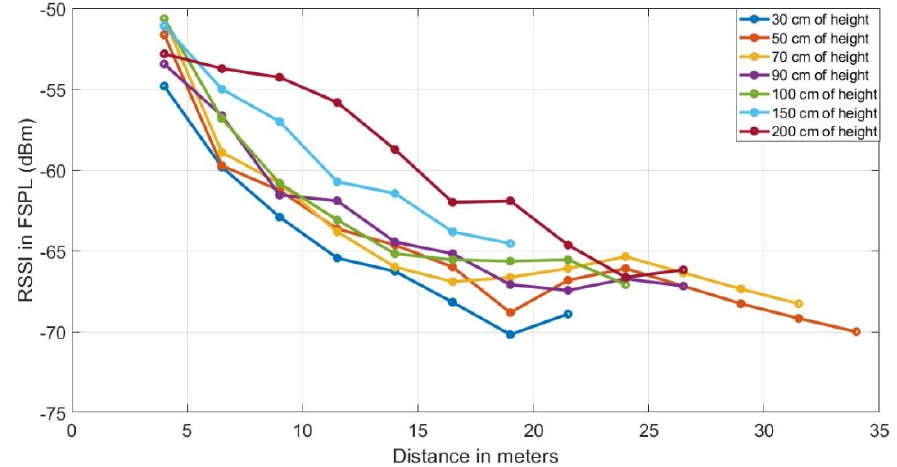
Figure 4. Received signal level average in dBm of the four locations, without line of sight obstructed (LOS) between transmitter (Tx) and receiver (Rx) nodes at different heights from the ground (30 cm, 50 cm, 70 cm, 90 cm, 100 cm, 150 cm).